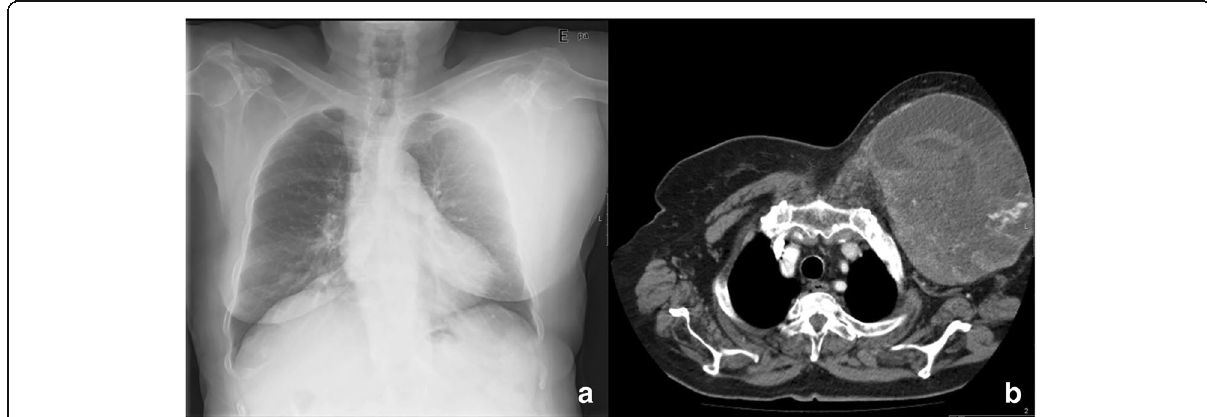
Fig. 2 Thoracic wall SFT. PA radiography ( a ) and enhanced axial CT images ( b ) showing a large well-defined exophytic mass with marked heterogenous enhancement. The diagnosis of SFT was obtained by a transthoracic needle